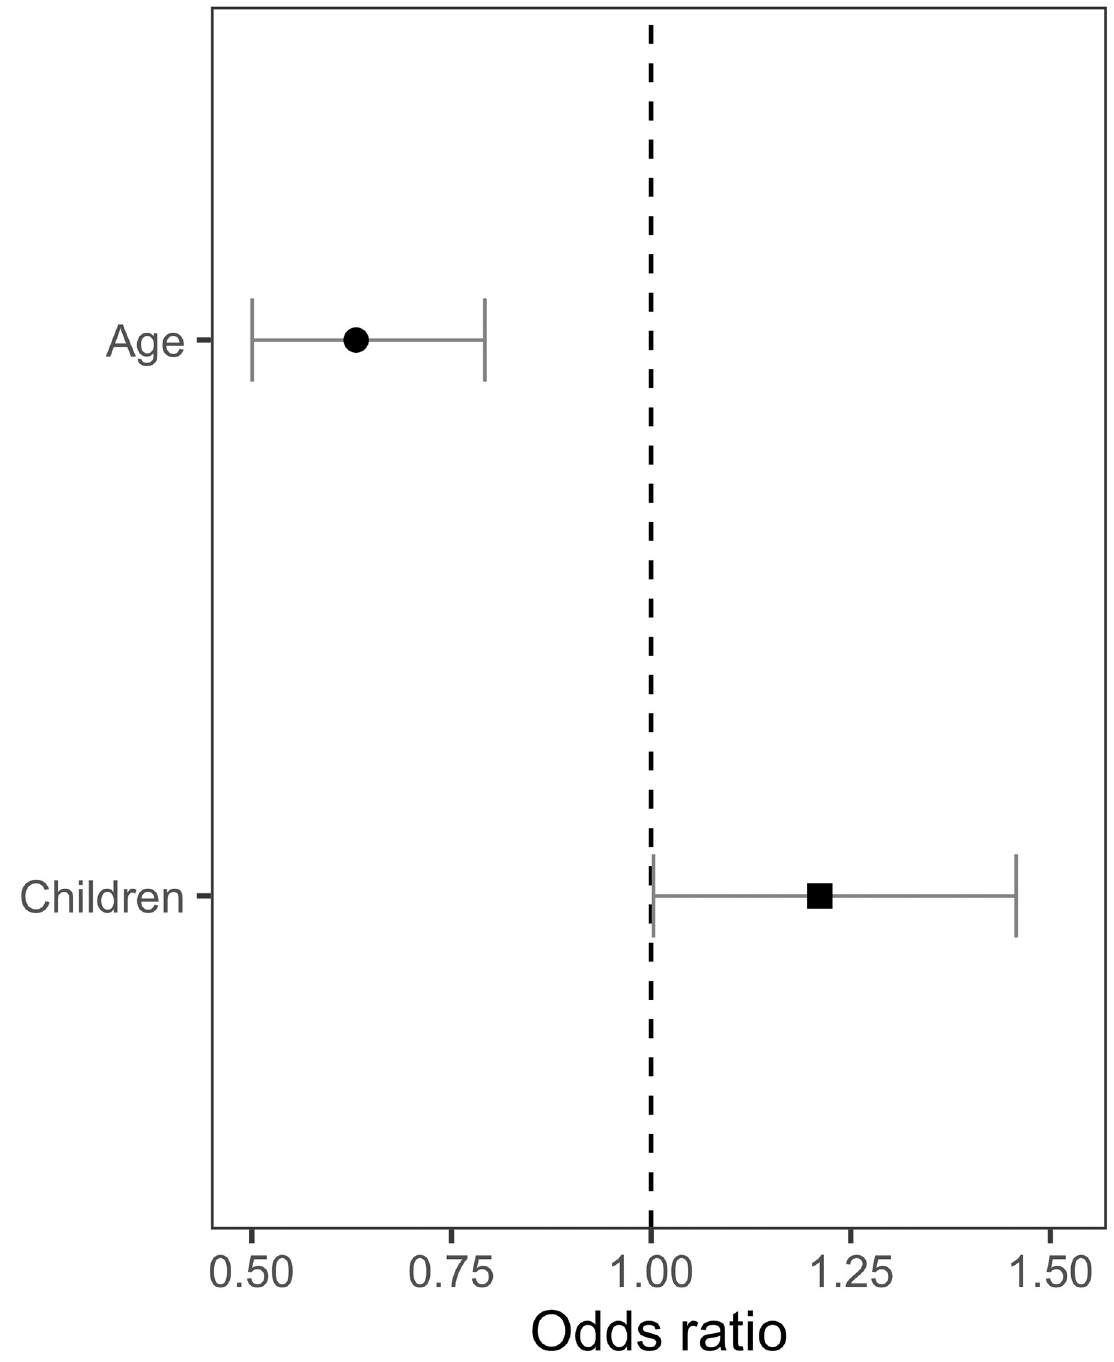
Fig 3. Statistically significant owner and dog parameters on experience help outcome. Experience help outcome odds predicted by statistically significant predictor variables: owner age (P < .001) and the number of children in the household (P = .043), calculated by the logistic regression